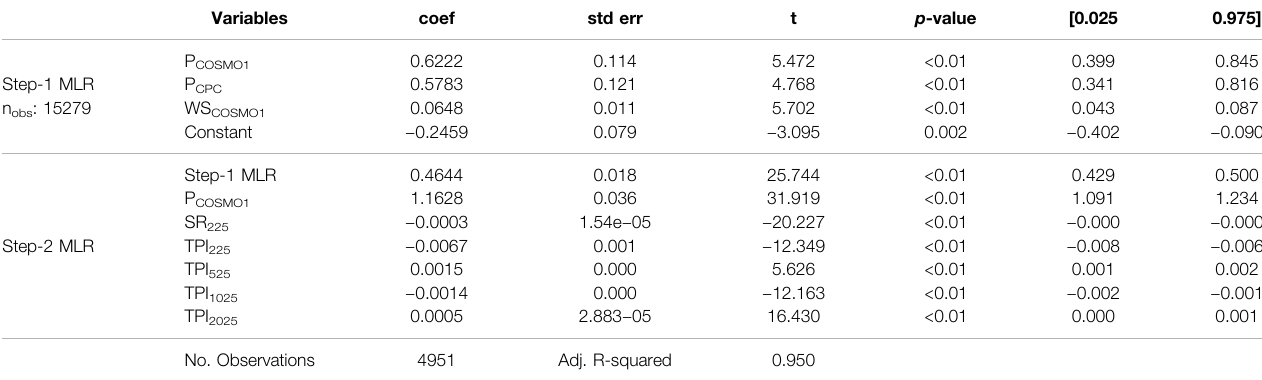
TABLE 2 | Signi fi cance of the variables and models.